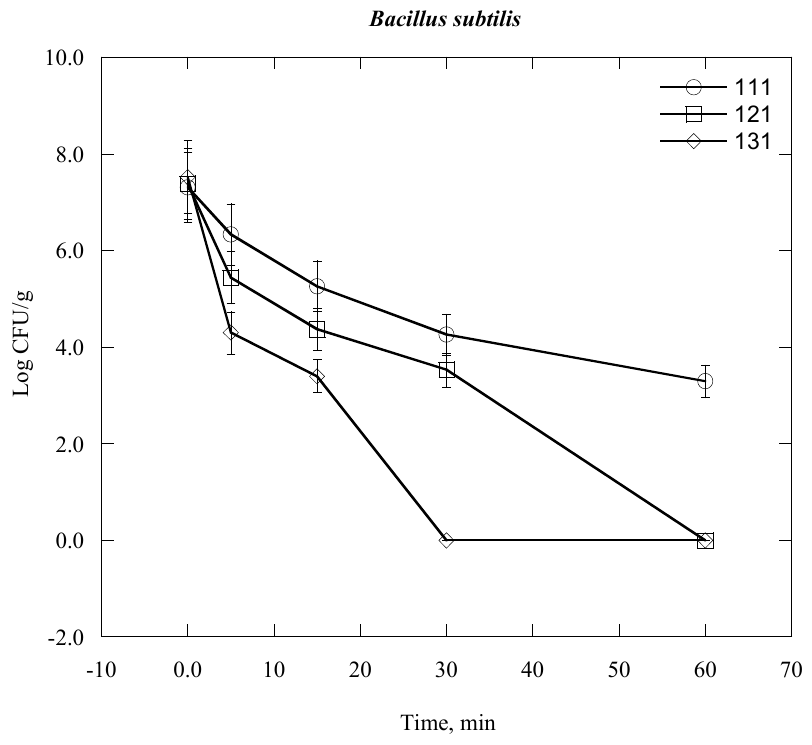
Figure 6. Inactivation of Bacillus subtilis in clinical solid waste using steam sterilization. Experimental conditions: (○), 111 °C (8 psi); (□), 121 °C (15 psi) and (◊), 131 °C (27